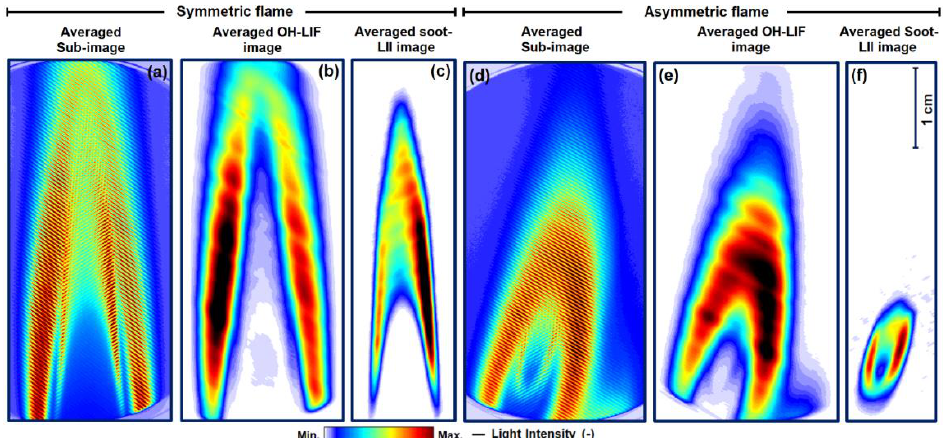
Figure 7. Symmetric flame: ( a – c ) averaged images corresponding to single-shots in Figure 6a–c. ( a ) Unprocessed sub-image, ( b ) processed OH-LIF, and ( c ) processed soot-LII. Asymmetric flame: the unprocessed averaged sub-image (different plane from Figures 5d and 7a) is shown in ( d ), isolated OH-LIF in ( e ), and isolated soot-LII in ( f ). The swirled diffusion flame is characterized by a more compact flame shape leading to lower soot-LII signals compared to the Bunsen-type flame.